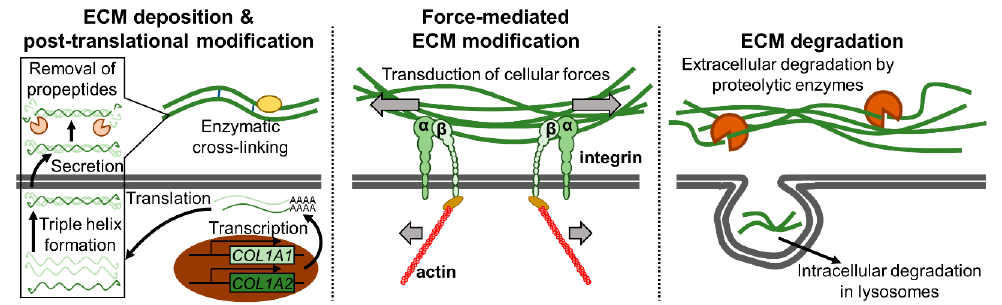
Figure 3. The ECM remodeling process. The three stages of ECM remodeling: (1) ECM deposition and post-translational modification ( left ), (2) force-mediated ECM modification ( middle ), and (3) ECM degradation ( right ) are illustrated with collagen I as an example. In the ECM deposition and post-translational modification step, individual collagen chains are first transcribed/translated. The collagen chains then form a triple helix, after which they are secreted, and the propeptides necessary for triple helix formation are removed. Secreted collagen fibers undergo various modifications such as enzymatic cross-linking. In the force-mediated ECM modification step, cellular forces are transduced via ECM receptors such as integrins to deform and align collagen fibers. Finally, in the ECM degradation step, collagen fibers are degraded extracellularly via various proteolytic enzymes or intracellularly in lysosomes following internalization.